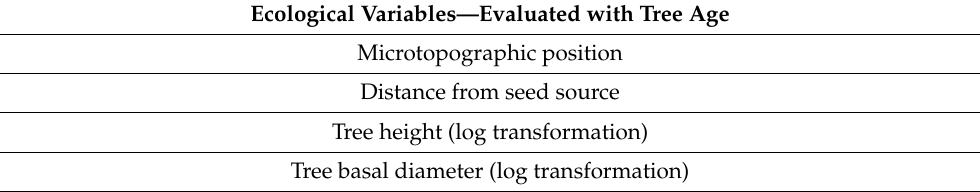
Table 4. Variables used to test relationships in the age of trees. The variables include both spatial and growth variables of